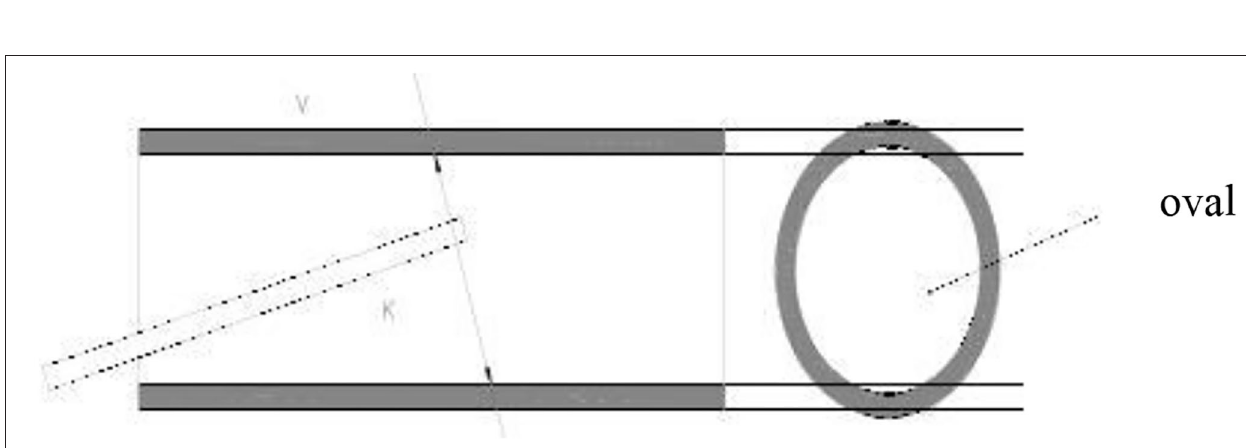
Frontiers in Surgery |